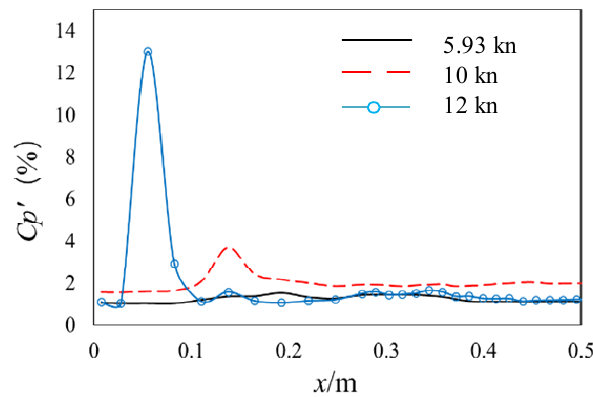
Figure 14. At three velocities.